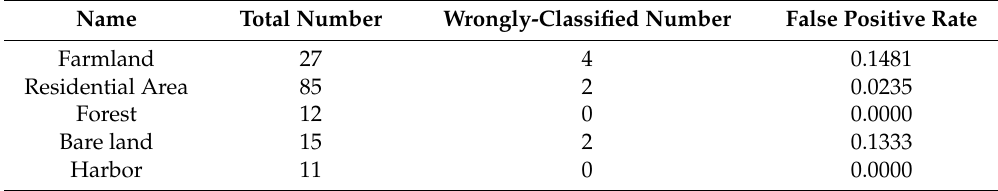
Table 2. Number and false positive rate of different types of non-airport